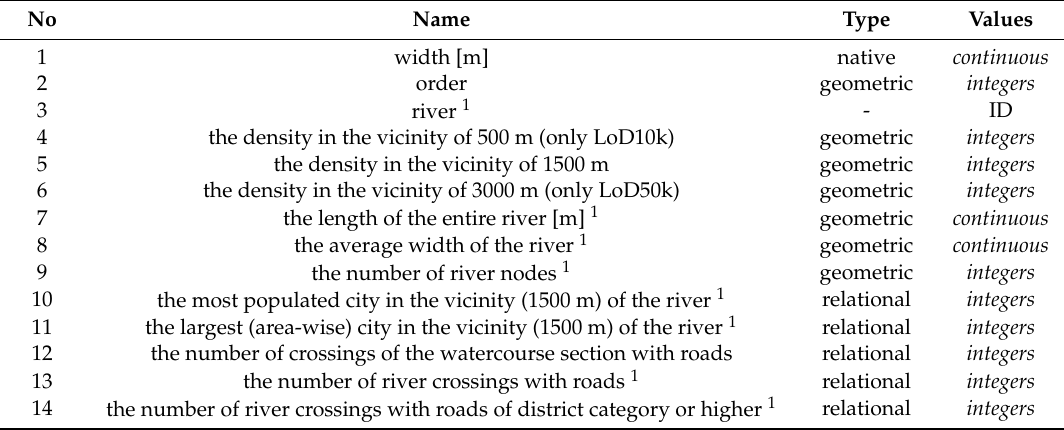
Table 10. Attributes of sections of watercourses in model data along with the indication of the types of attributes and their values; source: own